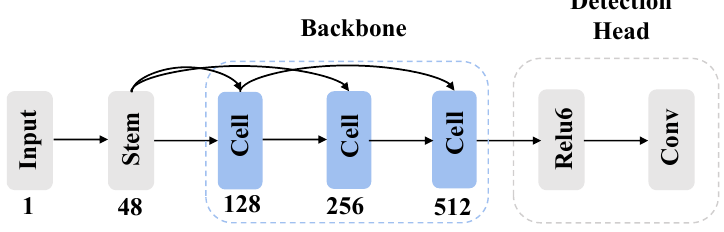
Figure 7. Darts_Tiny.